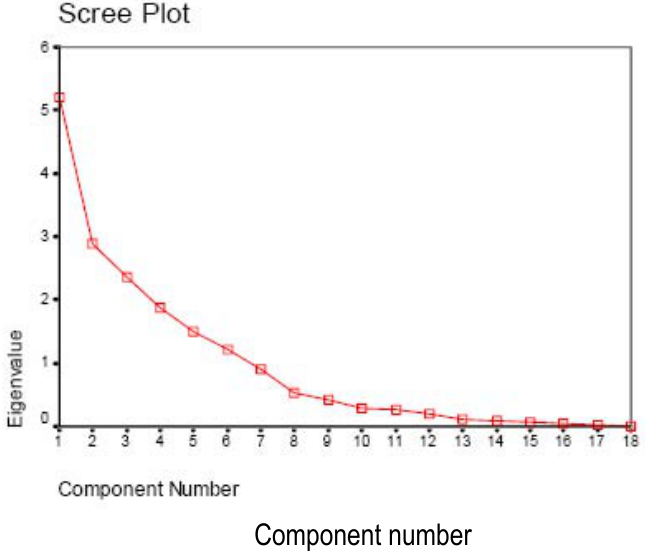
Fig. 1: Scree plot of eigenvalues versus number of